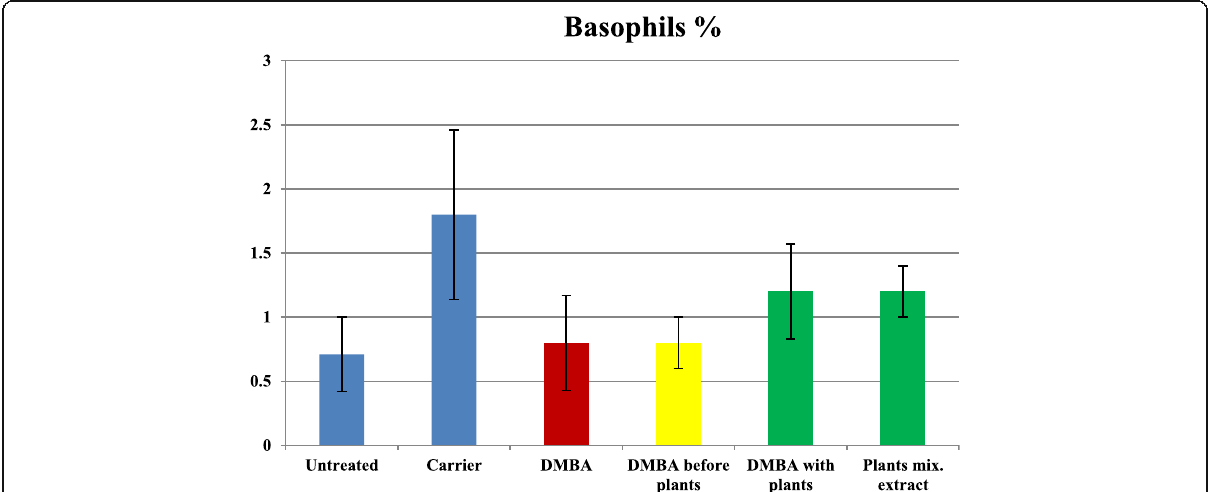
Fig. 8 Basophil percentage in the different rat groups. Standard errors are indicated on the bars and the significance levels are shown in Table 1